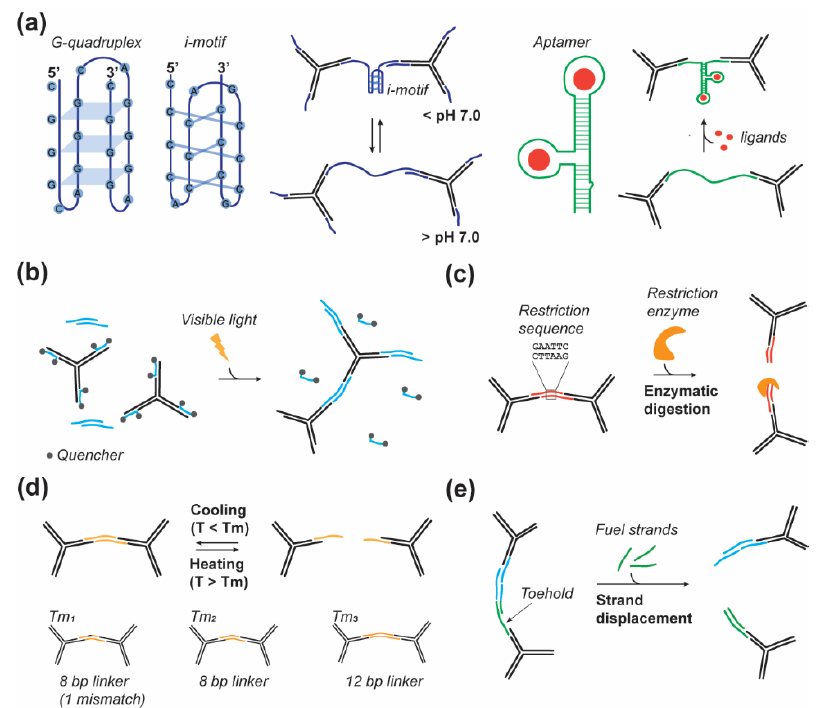
Figure 2. Responsive DNA linkers. ( a ) G-quadruplex motif, i-motif, and aptamers used to control mechanical properties of DNA hydrogels. ( b ) Photoresponsive assembly of DNA hydrogels. ( c ) Enzymatic digestion of DNA hydrogels. ( d ) Thermoresponsive DNA hydrogels. ( e ) Strand displacement method used to control DNA hydrogel assembly.